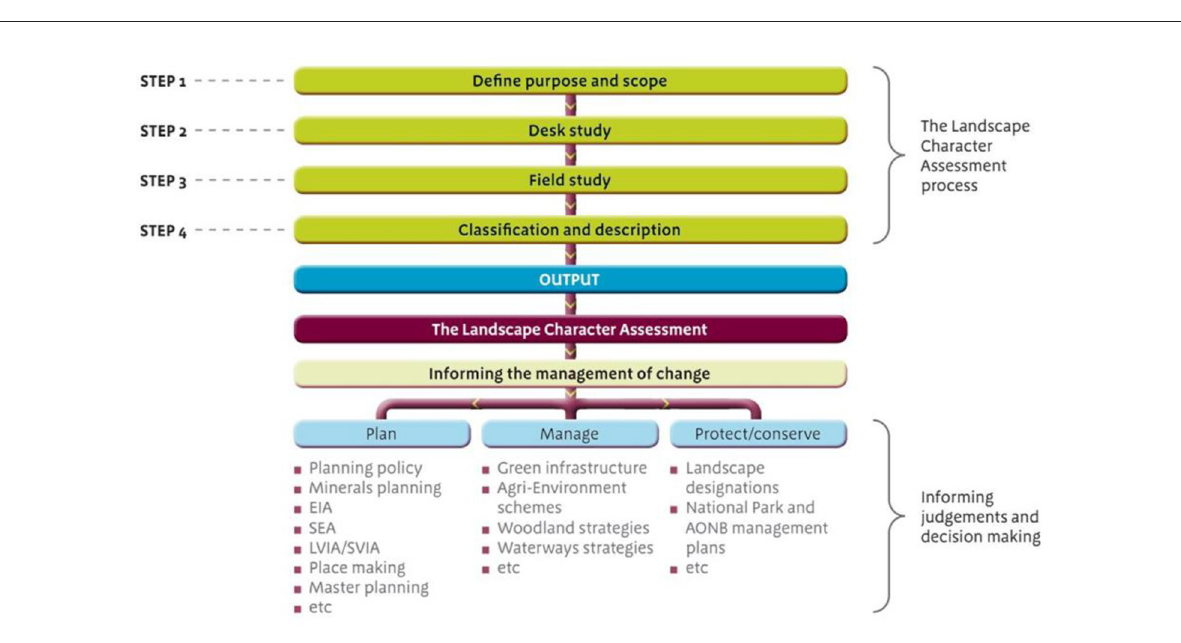
FIGURE3 Landscape Character Assessment process. Source: Natural England (LI Technical Information Note,